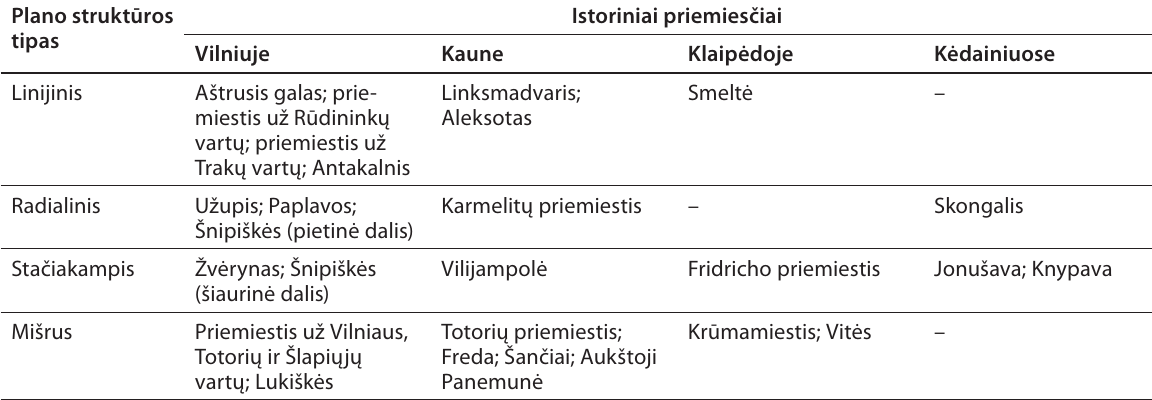
Table 2. Types of plan structure in historic suburbs